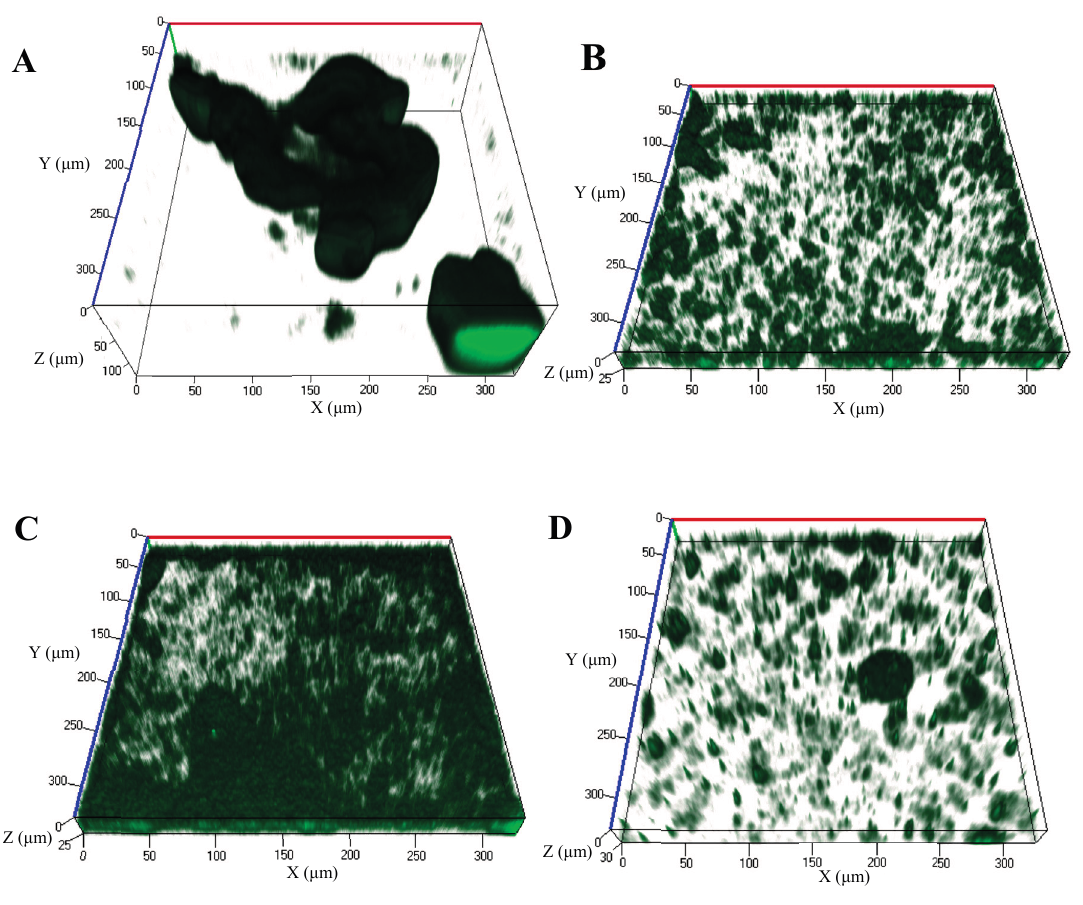
Figure 1. Biofilms of P. aeruginosa PA01 harboring the green fluorescence protein (GFP) expressing vector pMRP9-1 were grown in flow cell reactors in EPRI media, in the continuous presence of different concentrations of cis -2-decenoic acid ( cis -DA). ( A ) Control (media); ( B ) 1 nM of cis -DA; ( C ) 1 μ M of cis -DA; ( D ) 1 mM cis -DA. Following 96 h of culture, biofilms were observed using a confocal microscope at a 400×